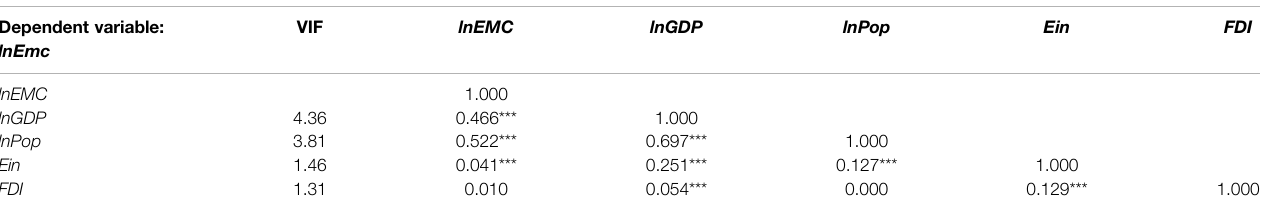
TABLE 3 | Correlation coef fi cient matrix and VIF tests for lnEmc .